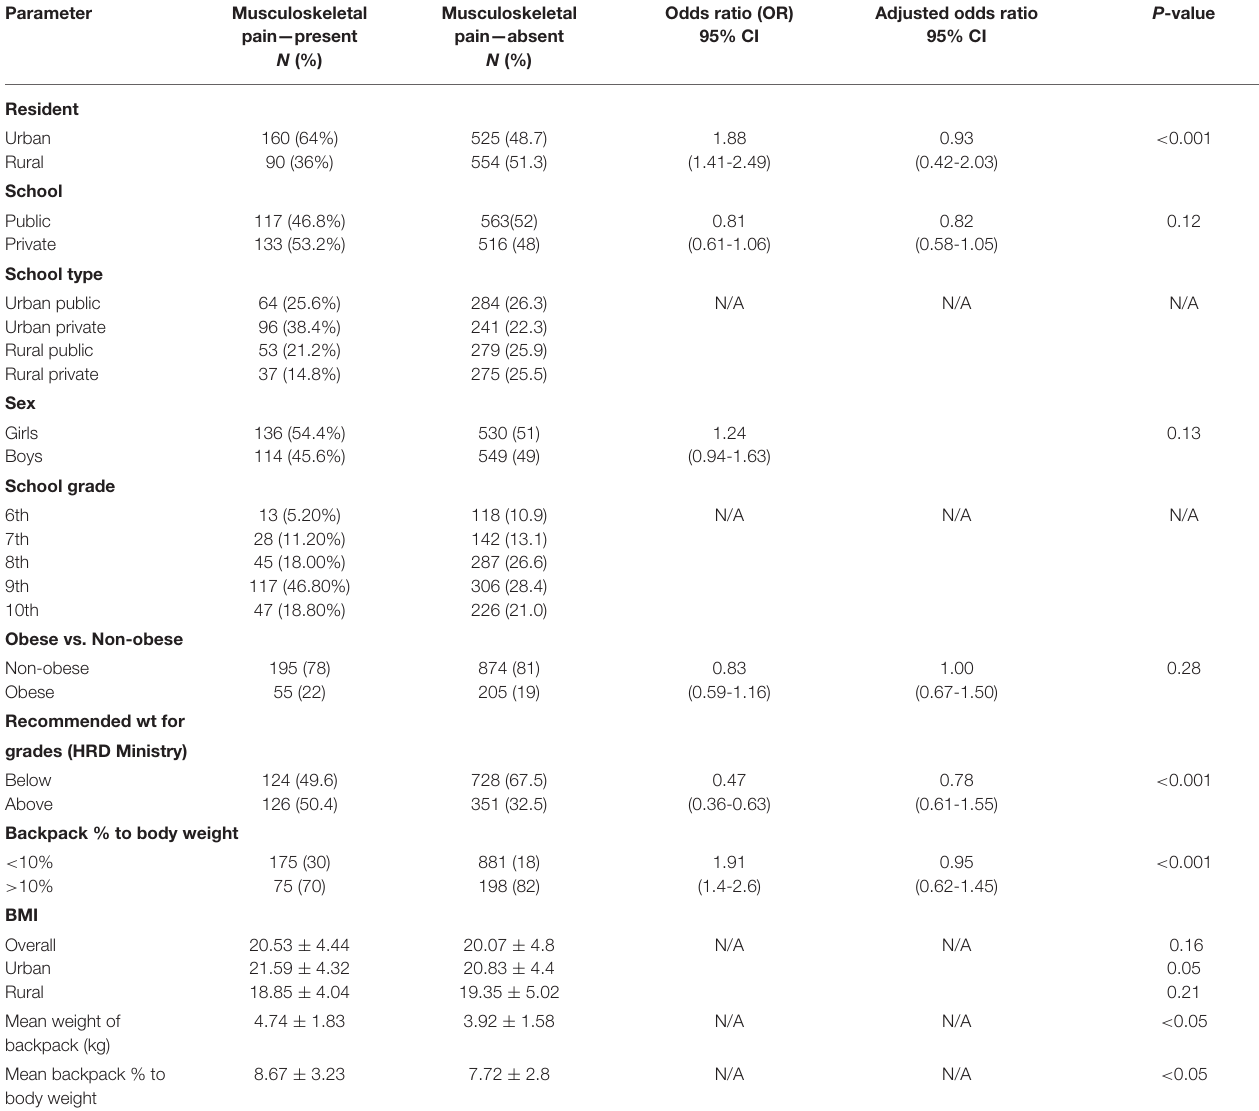
TABLE 4 | Risk factors associated with musculoskeletal